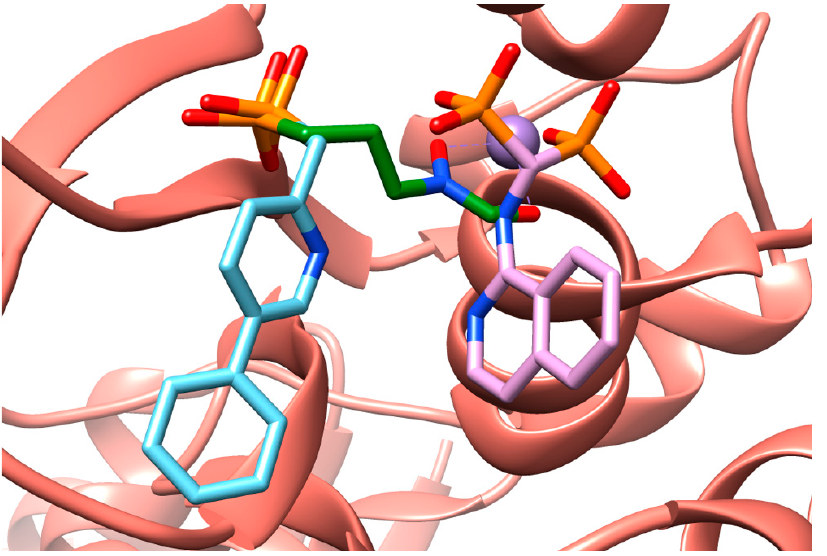
Figure 46. Superposition of fosmidomycin (green) PDB 1ONP, compound 235 (blue) PDB 3ANM and compound 232 (pink) PDB 1T1R in the structure of Ec DXR (salmon) PDB 1ONP .